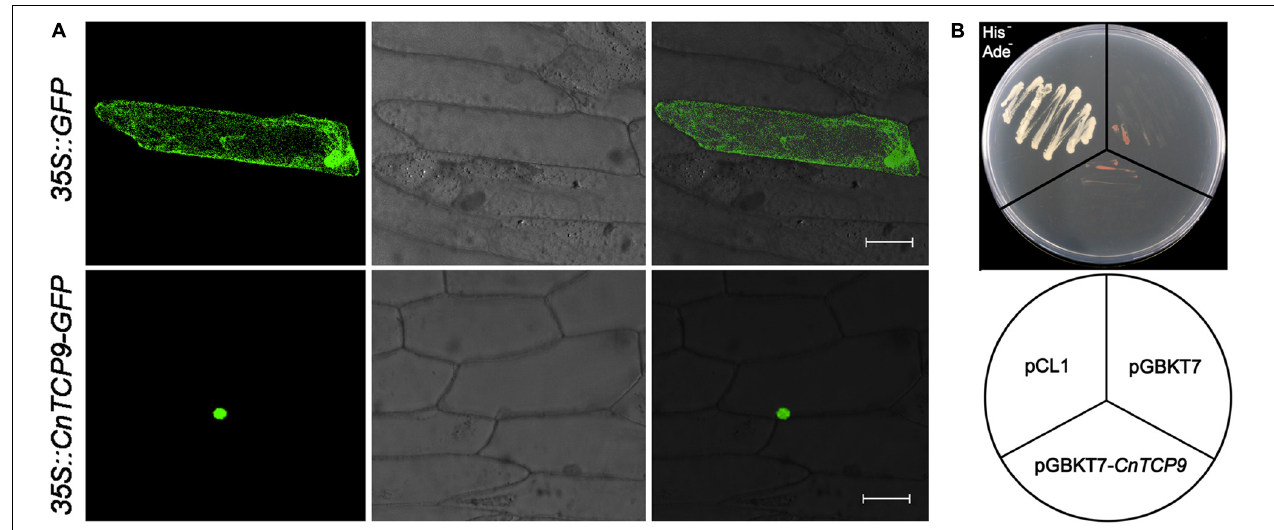
FIGURE 4 | Subcellular localization and transcriptional activation. (A) Subcellular localization of CnTCP9 protein in the onion epidermis cells. Onion epidermis cells were transformed with 35S:GFP as a control; bar = 50 µ m. (B) Transcriptional activation assays of CnTCP9 via yeast one-hybrid